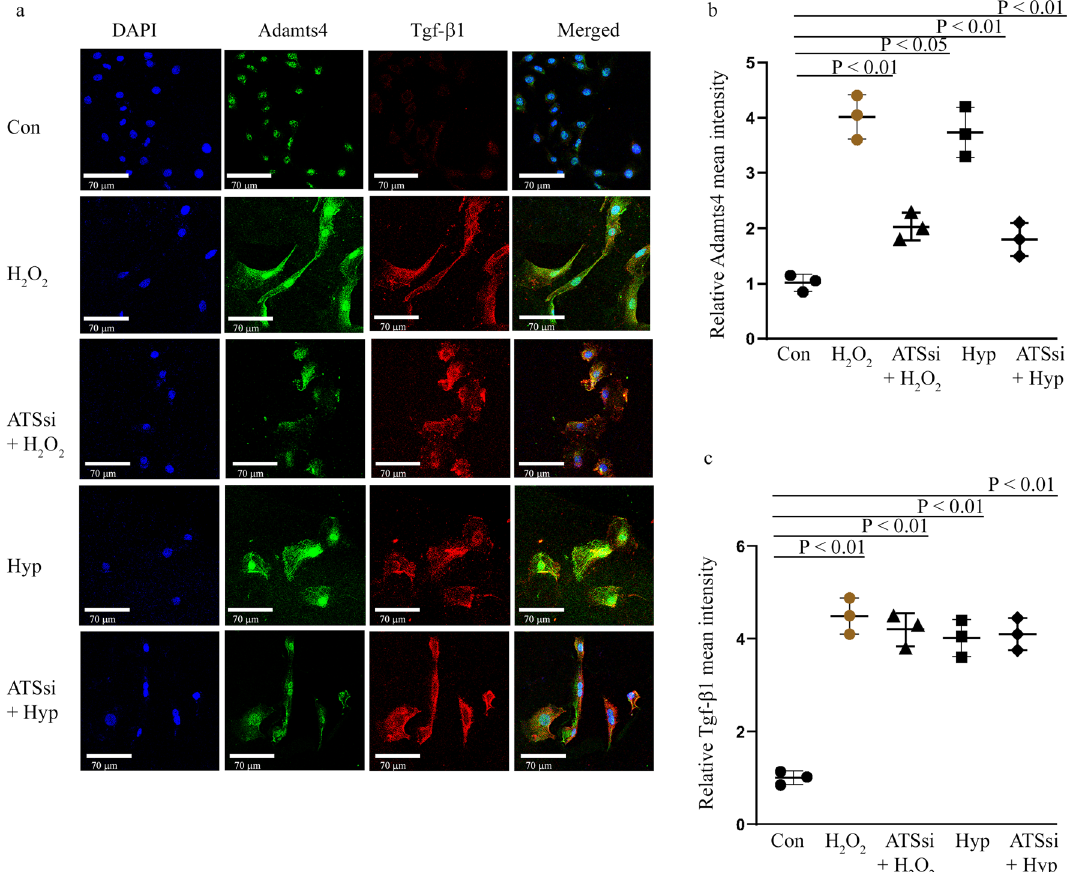
Figure 7. Tgf-β1 expression remains unaffected by Adamts4 knockdown. IF with anti-Adamts4 (shown in green) showed downregulation of Adamts4 following Adamts4 loss of function along with injury treatments. Adamts4 levels were found to decrease to 2 and 1.8 folds in the ATSsi + H 2 O 2 and ATSsi + Hyp groups in comparison to the 4 and 3.7 folds increase observed for only H 2 O 2 and Hyp treatments ( a and b ) but Tgf-β1 remained largely unaffected by this loss of function of Adamts4 and as shown by staining with anti-Tgf-β1 (shown in red) where the levels of Tgf-β1 were 4.5 and 4.0 for H 2 O 2 and Hyp groups and 4.2 and 4.1 for ATSsi + H 2 O 2 and ATSsi + Hyp groups (a and c). DAPI (shown in blue) was used as nuclear stain. Differences between groups H 2 O 2 and ATSsi + H 2 O 2 , and Hyp and ATSsi + Hyp were not found to be significant. n = 3, data analyzed and expressed as mean ± SD. Differences were considered statistically significant for p <